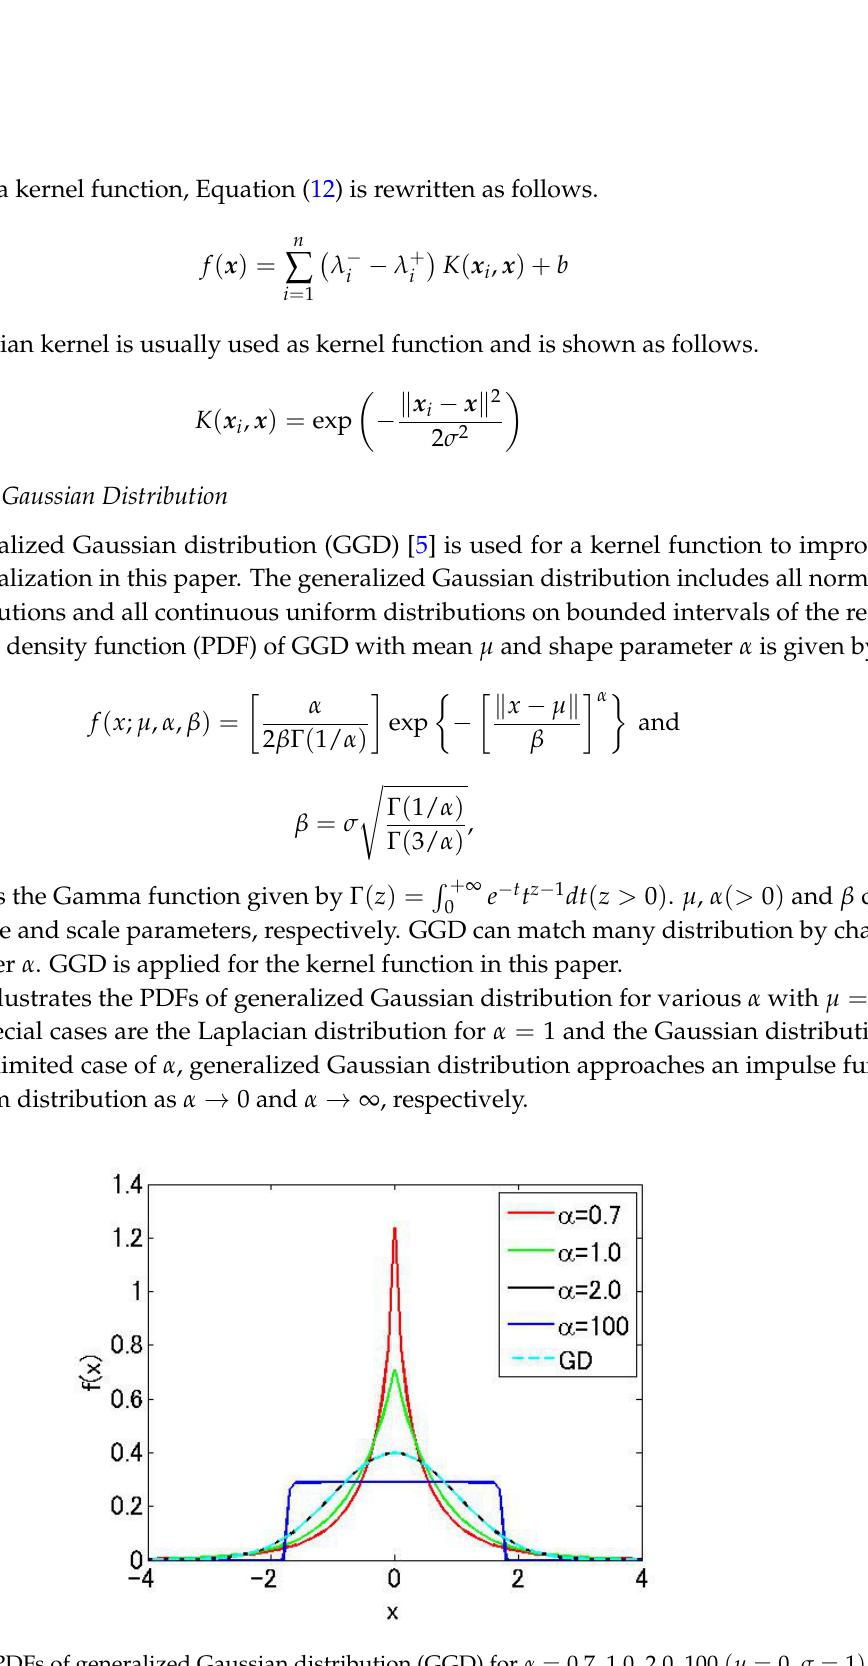
Figure 3. PDFs of generalized Gaussian distribution (GGD) for α = 0.7, 1.0, 2.0, 100 ( µ = 0, σ = 1 )